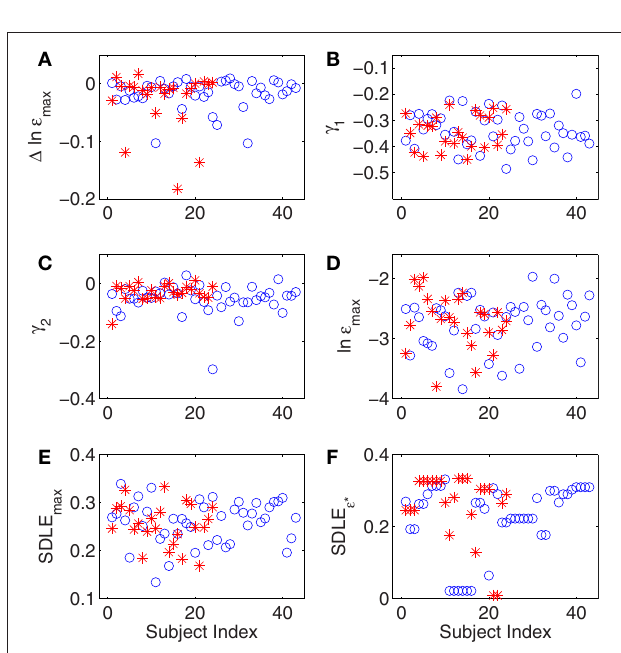
FIGURE 5 | (A–F) Summary of SDLE analysis, where blue circles and red stars are for control and CFS subjects, respectively (see text for more details about each metric).